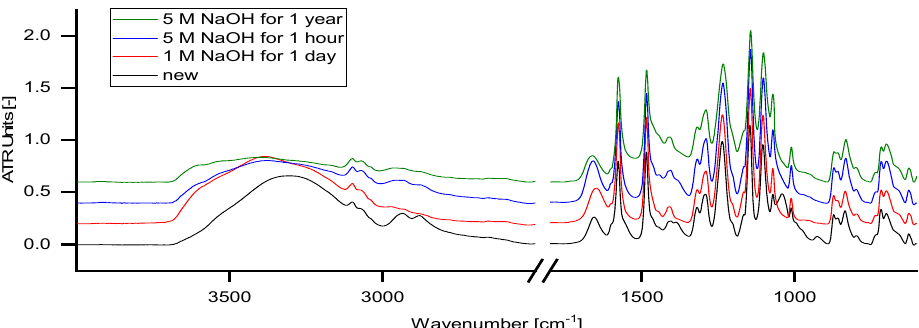
Figure 11. ATR–IR spectra of membranes stored in NaOH solutions with different concentrations (1–5 molar) for varying periods (1 h–1 year).